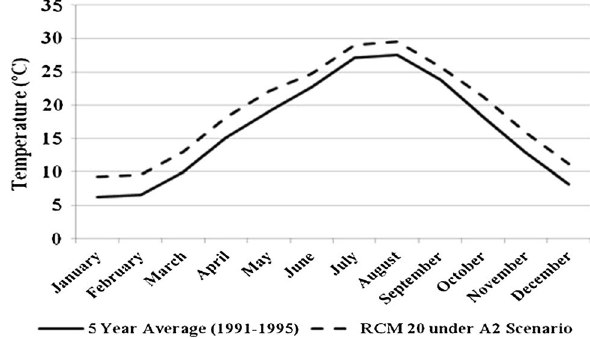
Fig. 8 Temperature change pattern after 100 years